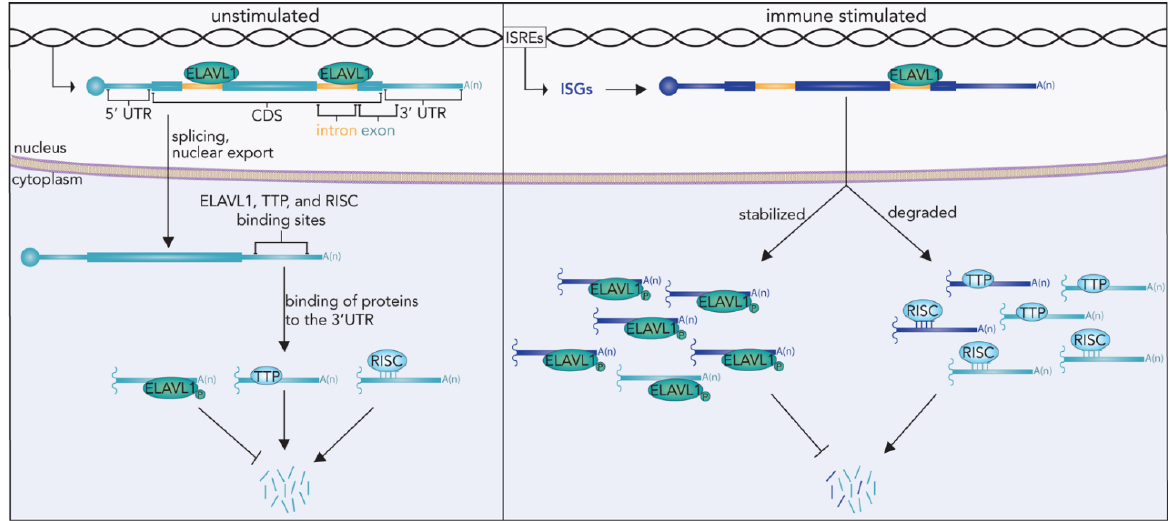
Figure 5. ELAVL1, TTP, and RISC compete for AREs on the 3′ UTR of mRNA. Nuclear ELAVL1 binds to intronic regions of an mRNA to assist in proper splicing. Upon immune stimulation and subsequent expression of interferon stimulated genes (ISGs), cytoplasmic ELAVL1 is phosphorylated and preferentially binds AU rich regions (AREs) within the 3′ untranslated region (UTR) of ISGs, thus enhancing the stability of the transcripts. AREs of the 3′ UTR can also be bound by the RNA-induced silencing complex (RISC) or TRISTETRAPROLIN (TTP), both of which are implicated in degradation of the RNA. The 3’ UTRs bound by ELAVL1, TTP, or RISC are represented as abbreviated sections of full-length RNA transcripts.